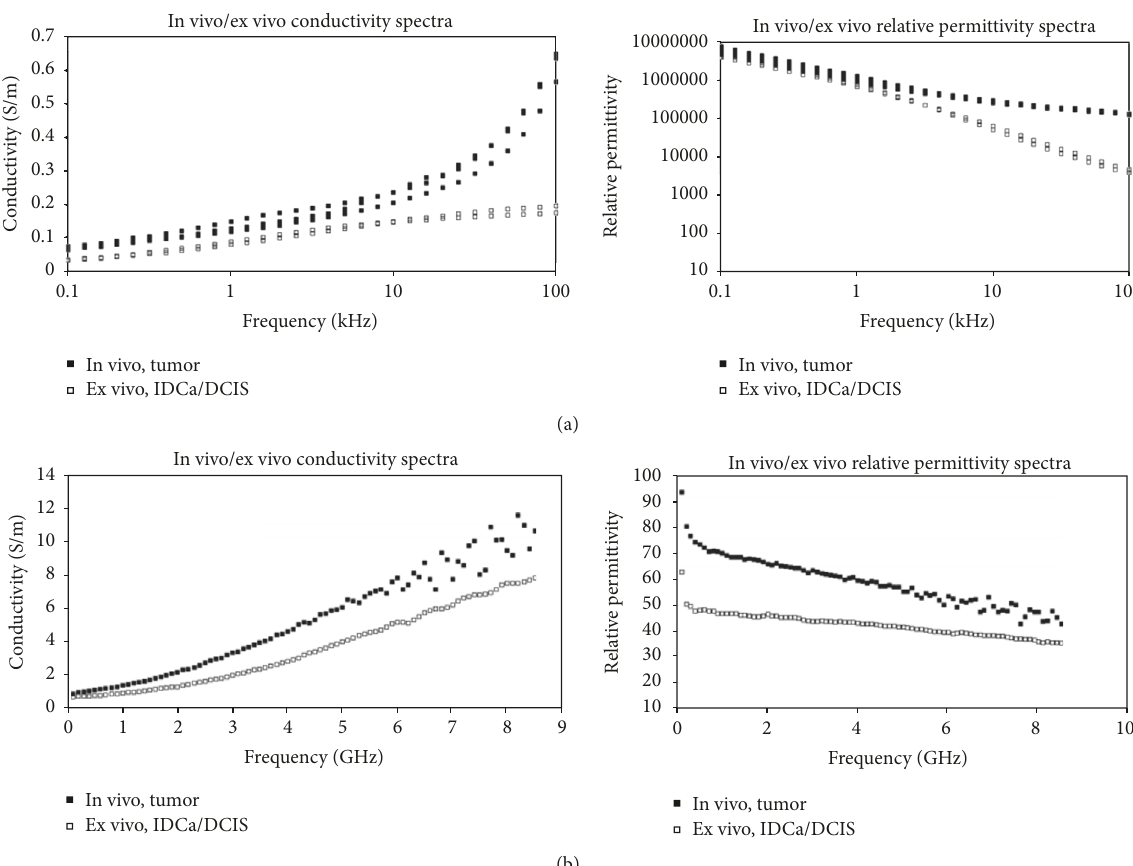
Figure 6: In vivo versus ex vivo dielectric spectra (electrical impedance spectroscopy (EIS) (a) and microwave impedance spectroscopy (MIS) (b)). Multiple spectra recorded for EIS are shown, while the average MIS spectrum is illustrated [16]. © Institute of Physics and Engineering in Medicine. Reproduced by permission of IOP Publishing. All rights reserved.